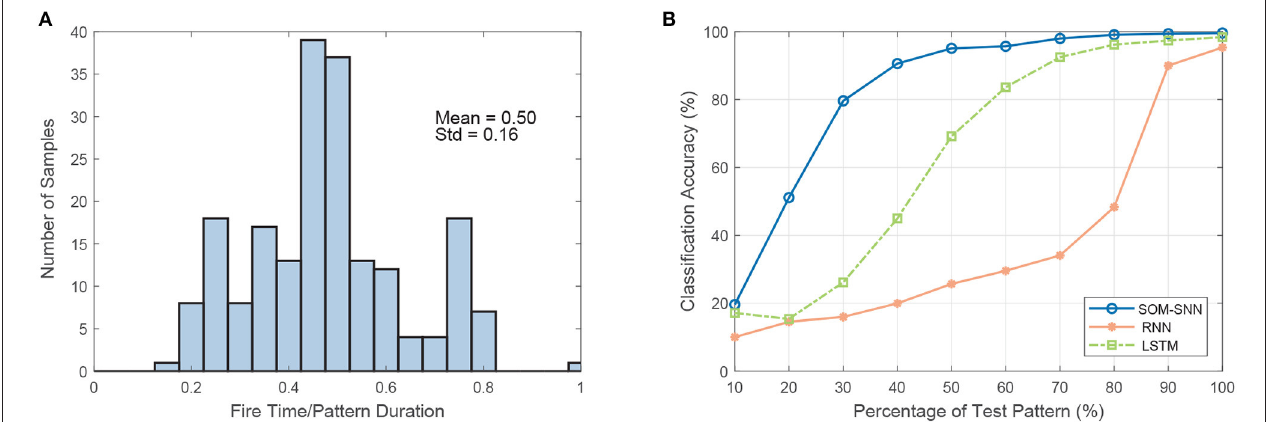
FIGURE 3 | The demonstration of the early decision making capability of the SNN-based classifier. (A) The distribution of the number of samples as a function of the ratio of decision time (spike timing) to sample duration on the RWCP test dataset. On average, the SNN-based classifier makes the classification decision when only 50% of the pattern is presented. (B) Test accuracy as a function of the percentage of test pattern input to different classifiers (classifiers are trained with full training